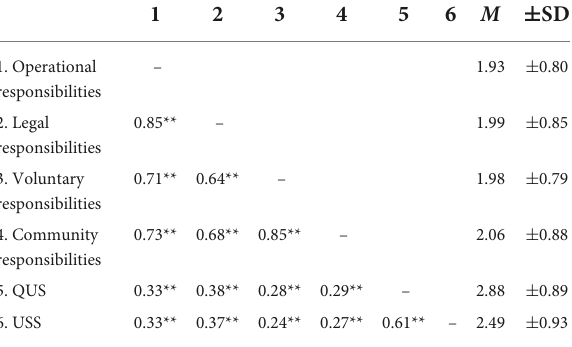
TABLE 4 Pearson correlations among USR aspects, QUS, and